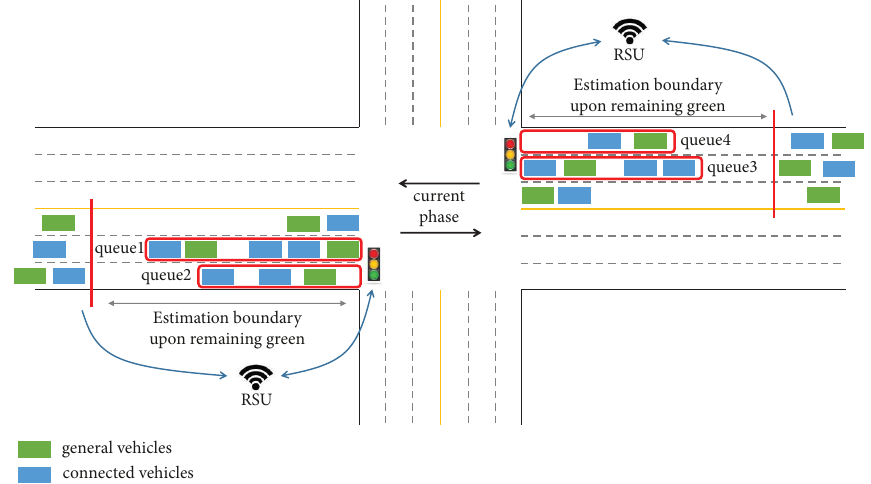
Figure 3: Concept of estimating the arrival times of vehicles at intersection by road lanes. Table 2: Description of variables related to intersection signal